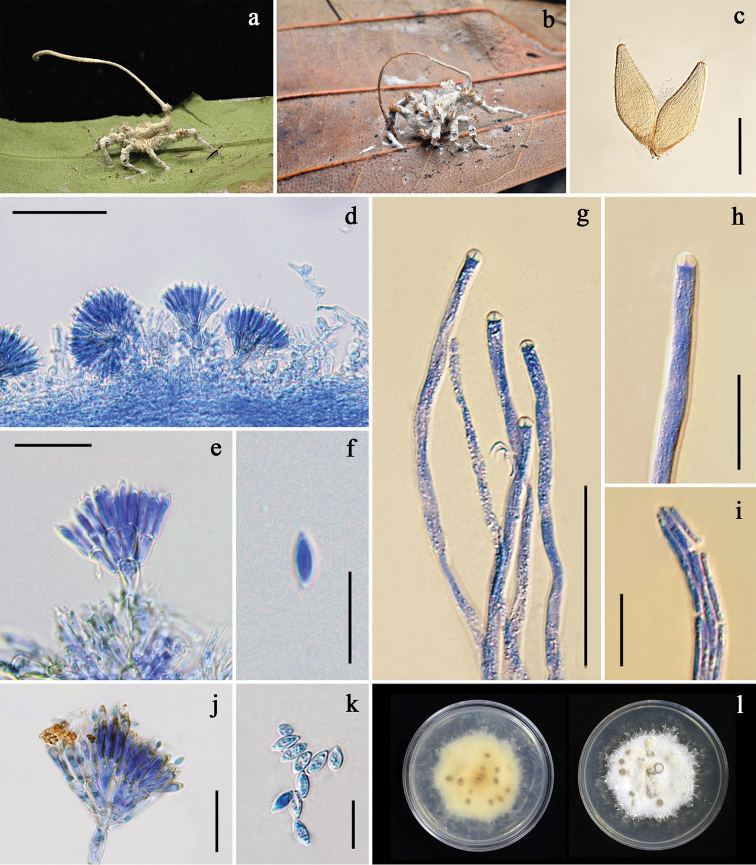
Gibellula
scorpioidesa fungus on a spider (BBH 29669) b fungus on a spider (BBH 31439) c perithecia (BBH 31439) d conidiophores arising on synnema (BBH 29669) e penicillate conidiophore (BBH 29669) f conidia (BBH 29669) g asci (BBH 31439) h ascus with apical apparatus (BBH 31439) i ascospores (BBH 31439) j penicillate conidiophore produced on PDAk conidia on PDAl colonies obverse and reverse on PDA at 25 °C after 4 months. Scale bars: 500 μm (c); 50 μm (d, g); 20 μm (e, h–j); 10 μm (f, k).